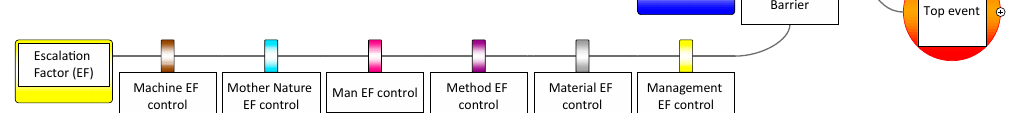
Figure 9. Escalation factor path with coloured barrier categories.